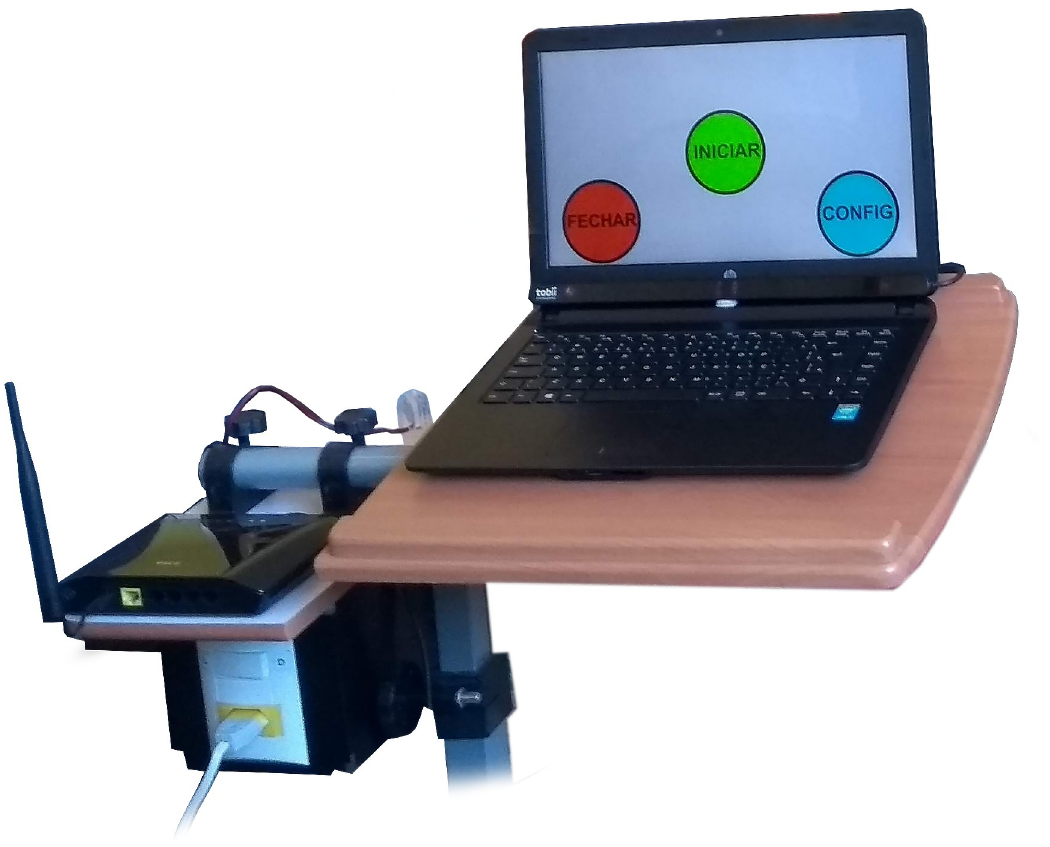
Fig 3. Portable table, eye tracker, and notebook computer are